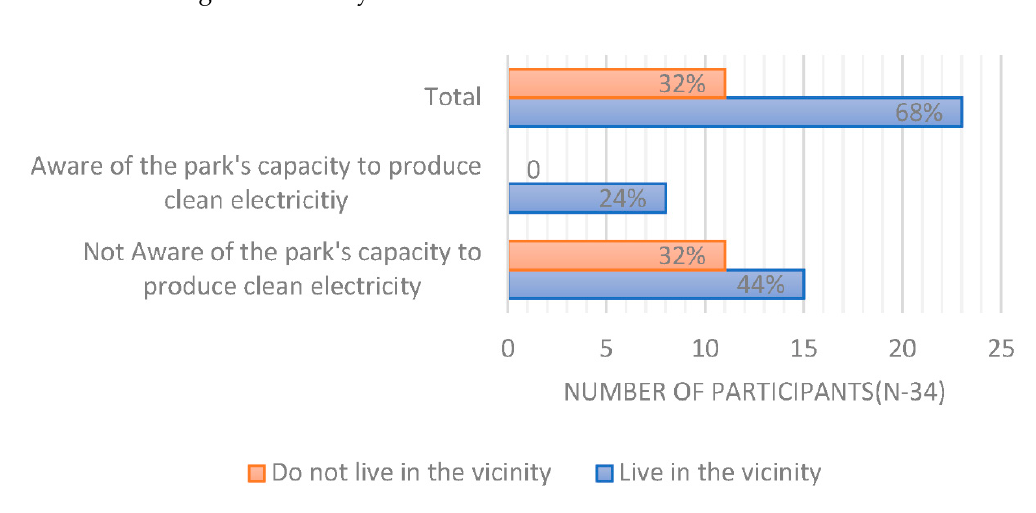
Figure 6. ( a ) Renewable energy sculpture used as a background for wedding photography; ( b ) geo-tags were pinned to the renewable energy sculpture. Images by the author.